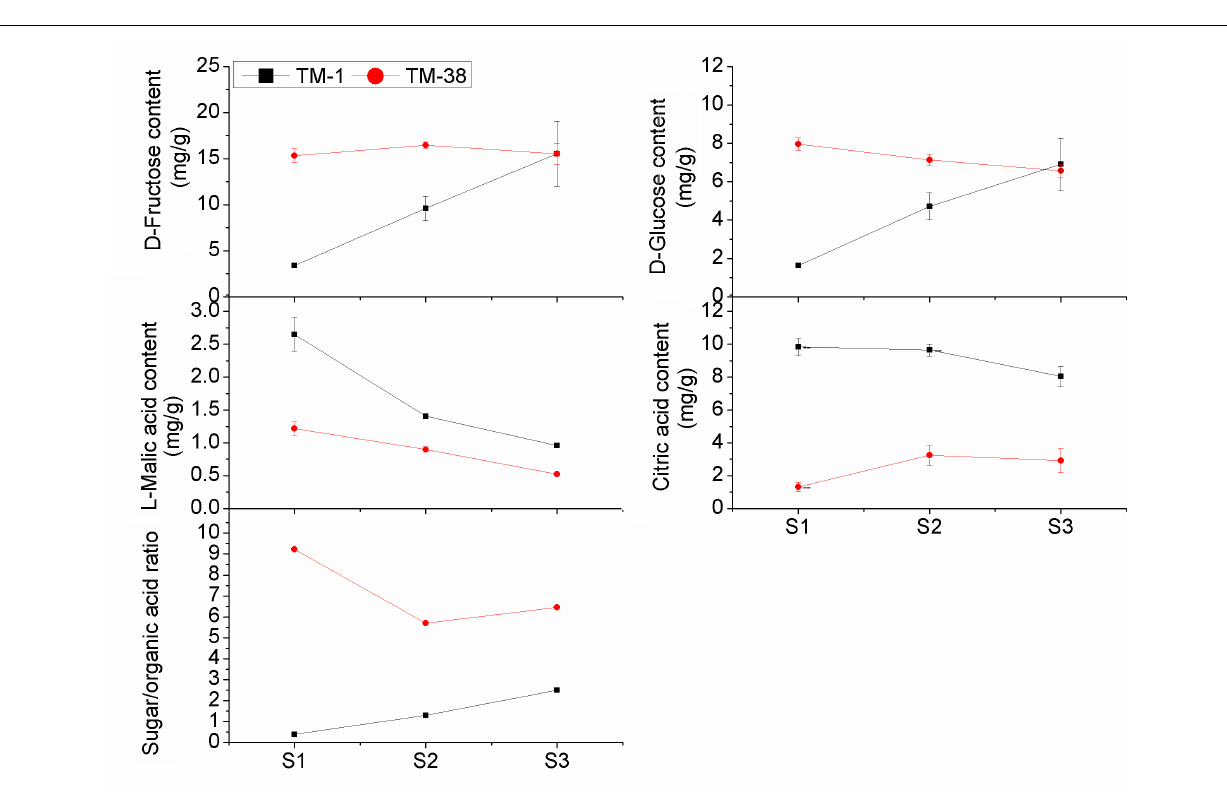
Frontiers in Genetics |